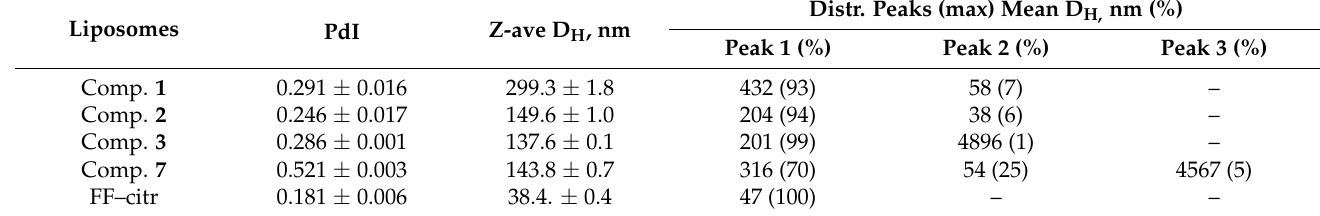
Table 5. DLS data of liposomes of 1,4-DHP amphiphiles 1 – 3 and 7 obtained with FF–citr. PdI is the polydispersity index; Z-ave D H is the diameter that represents the mean hydrodynamic diameter of all liposomes in the distribution. The mean hydrodynamic diameter, D H , depicts the hydrodynamic size of the main population of the tested sample. Dispersions were prepared by the REV